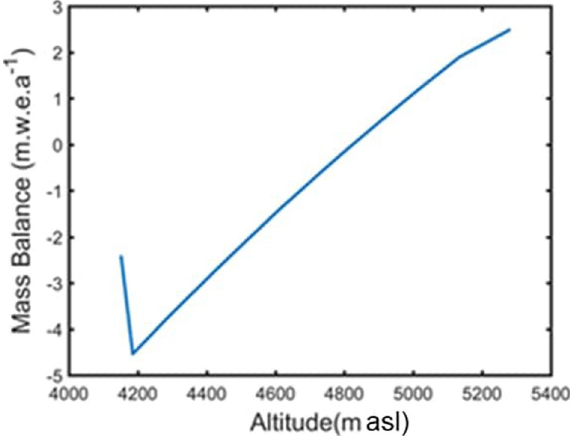
Figure 3. Mean, annual mass balance profile of the main stream of the Gepangath glacier over the period 2002–2011. This profile was modelled by using the ERA reanalysis data and daily meteorological records from the IMD observatories at Manali and Kaza. The mass balance profile for the tributary was estimated by adjusting the main stream’s mass balance curve wrt altitude of the tributary. (URL: www. mathw orks. com).